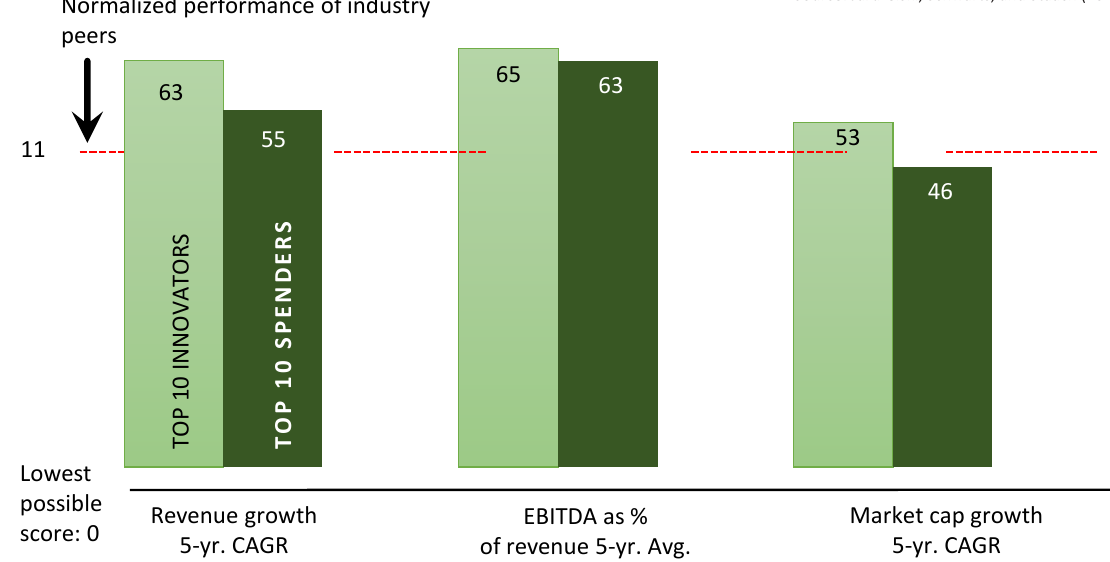
Figure 1. Normalized performance of top 10 innovators versus top 10 R&D spenders, showing, on an indexed basis, the innovators consistently outperforming the spenders on all 3 most important financial